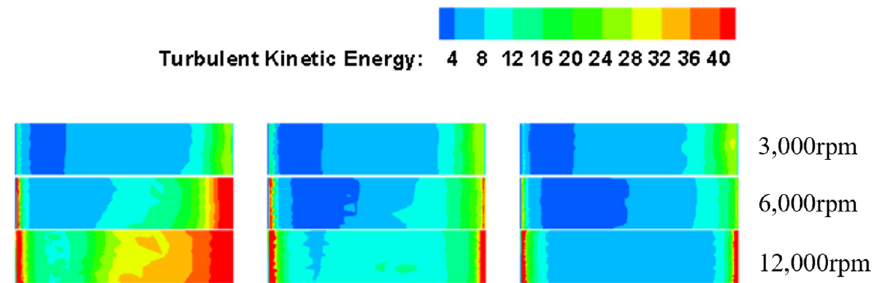
Figure 13. Turbulent kinetic energy cloud diagram of cross section in tooth cavity with 5 mm pitch at different rotating